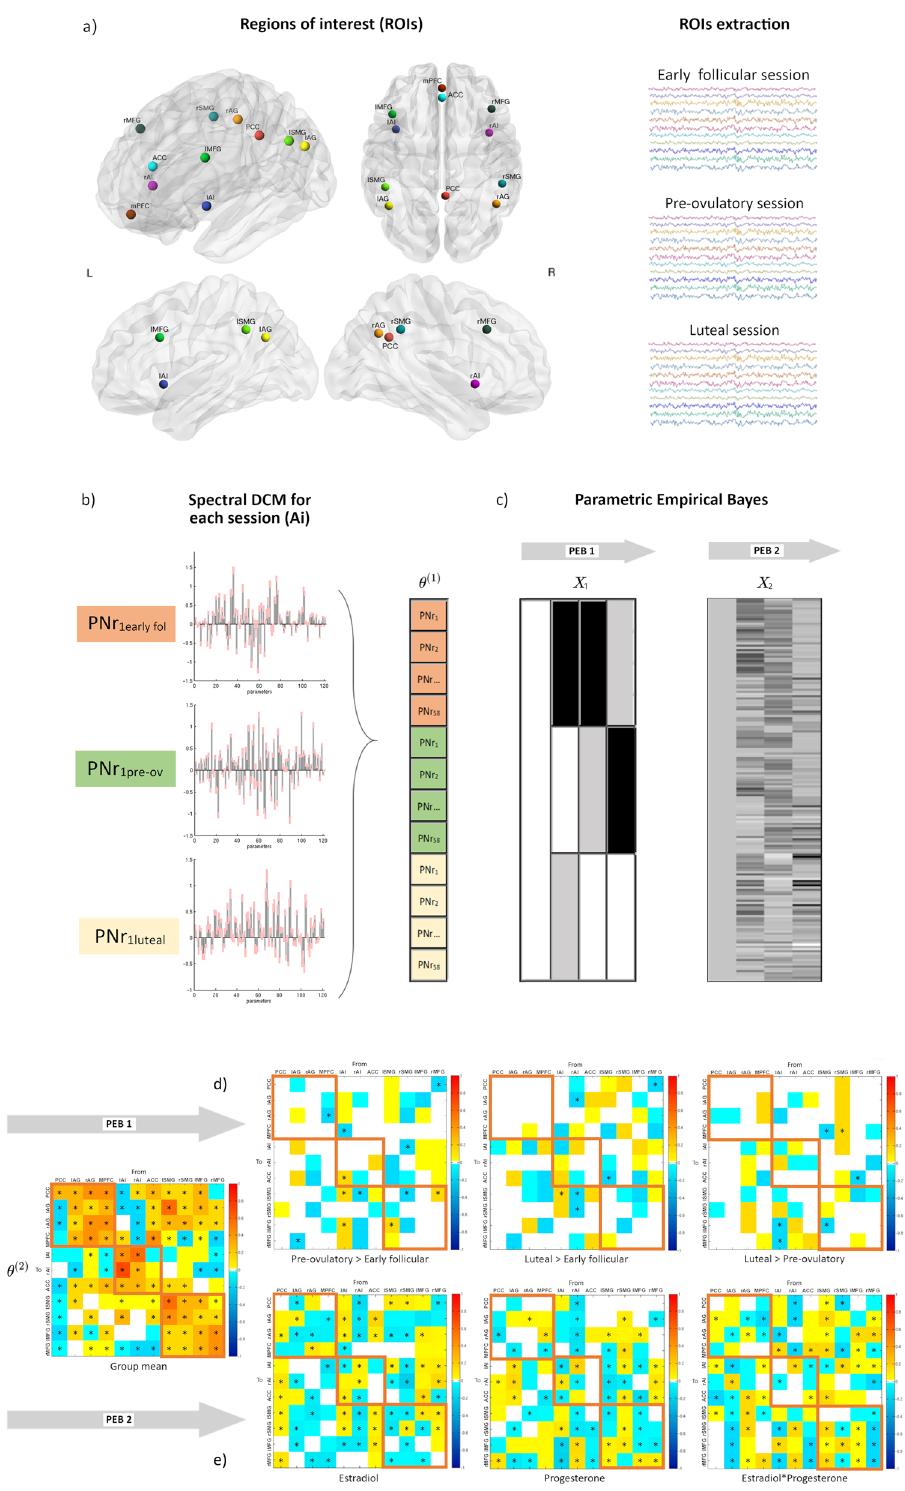
− 0.17, Pp = 100%) (Supplementary Data fi le 1, Fig. 3b). The effective connectivity from the SN to the anterior DMN followed an opposite lateralization, being the strongest during the early follicular phase from the left AI to mPFC (Ep = − 0.11, Pp = 95%), and negatively related to estradiol (Ep = − 0.05, Pp = 97%). The negative impact of higher estradiol levels was partially reversed in the presence of high progesterone levels as